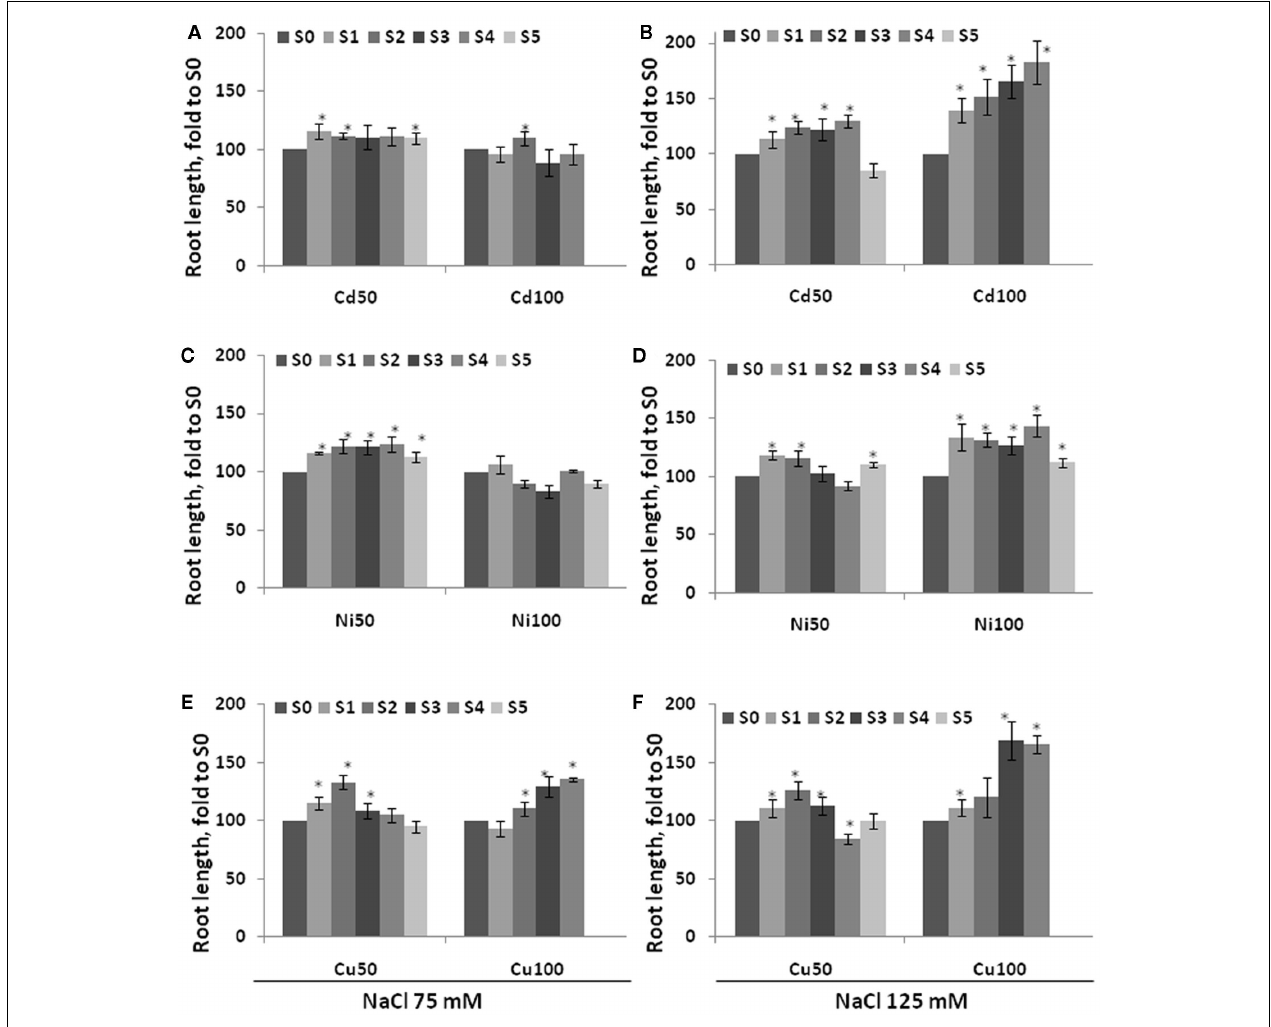
FIGURE 6 | Root length in the progeny of stressed plants exposed to high concentration of NaCl. Root length was measured in five consecutive generations of non-exposed plants and plants exposed to 50mM Cd 2 + or 100mM Cd 2 + (A,B) , 50 Ni 2 + or 100mM Ni 2 + (C,D) , 50mM Cu 2 + or 100mM Cu 2 + (E,F) . Plants were germinated and grown on MS medium supplemented with 75mM NaCl (A,C,E) and 125mM NaCl